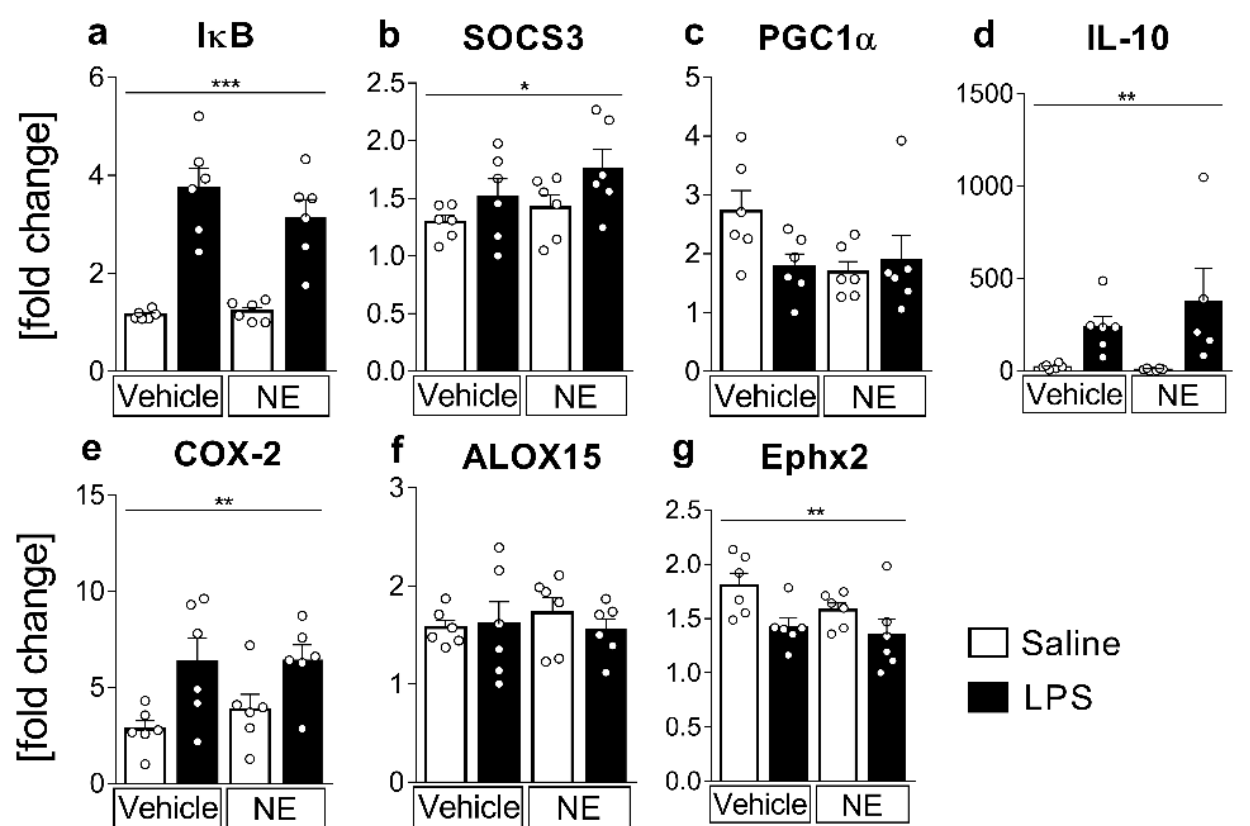
Figure 2. mRNA expression of inflammatory markers and lipid mediator metabolism: mRNA ex- pression was assessed for markers of inflammatory pathway activation ( a – d ) and lipid mediator metabolism enzymes ( e – g ). Cells were stimulated with lipopolysaccharide (LPS, 10 µ g/mL) or saline and simultaneously treated with norepinephrine (NE, 1 µ mol/L) or vehicle for 4 h. The 2- ∆∆ ct method was applied to present relative quantities as fold change of the lowest expression. Pro- inflammatory pathway-activation-marker inhibitor (I) κ B, ( a ) and suppressor of cytokine signaling (SOCS)3, ( b ) and the anti-inflammatory cytokine interleukin (IL)-10 ( d ) increased due to LPS stimula- tion. The rate-limiting enzyme for prostaglandin production, i.e., cyclooxygenase (COX)-2 ( e ), showed an LPS-induced increase, whereas there were reduced epoxide hydrolase (Ephx)2 ( g ) mRNA levels in LPS-stimulated groups. Peroxisome proliferator-activated receptor gamma coactivator ((PGC)1 α , ( c )) and arachidonate 15-lipoxygenase (ALOX15, ( f )) mRNA expression were not significantly affected by LPS-stimulation or NE treatment. n = 6 per group; two-factorial ANOVA, Bonferroni post hoc test, * main effect LPS stimulation; * p < 0.05, ** p < 0.01, *** p <